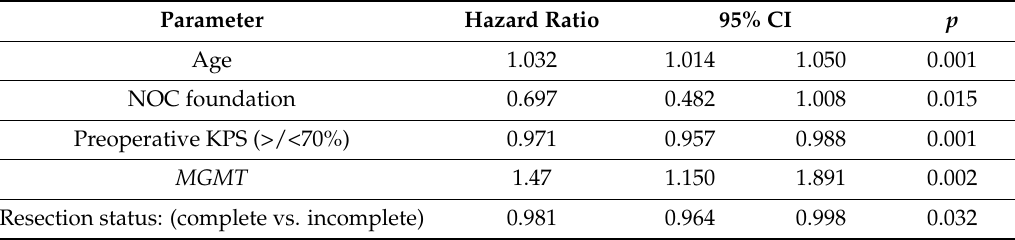
Table 3. Multivariate analysis of prognostic factors for overall survival in 149 patients with newly diagnosed GBM.